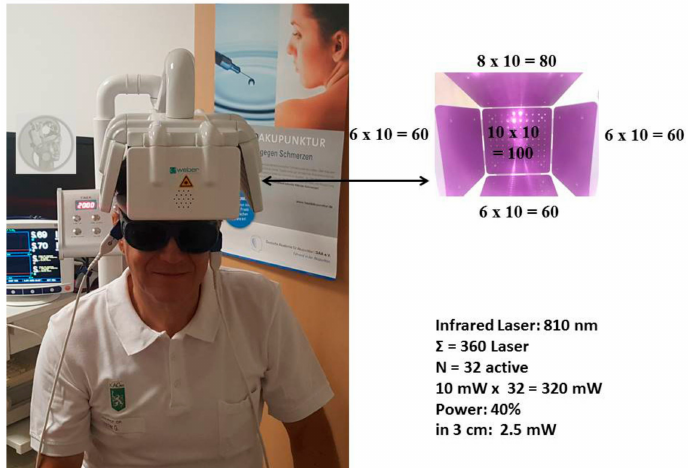
Figure 1. First measurement with the new transcranial laser stimulation helmet from Weber Medical